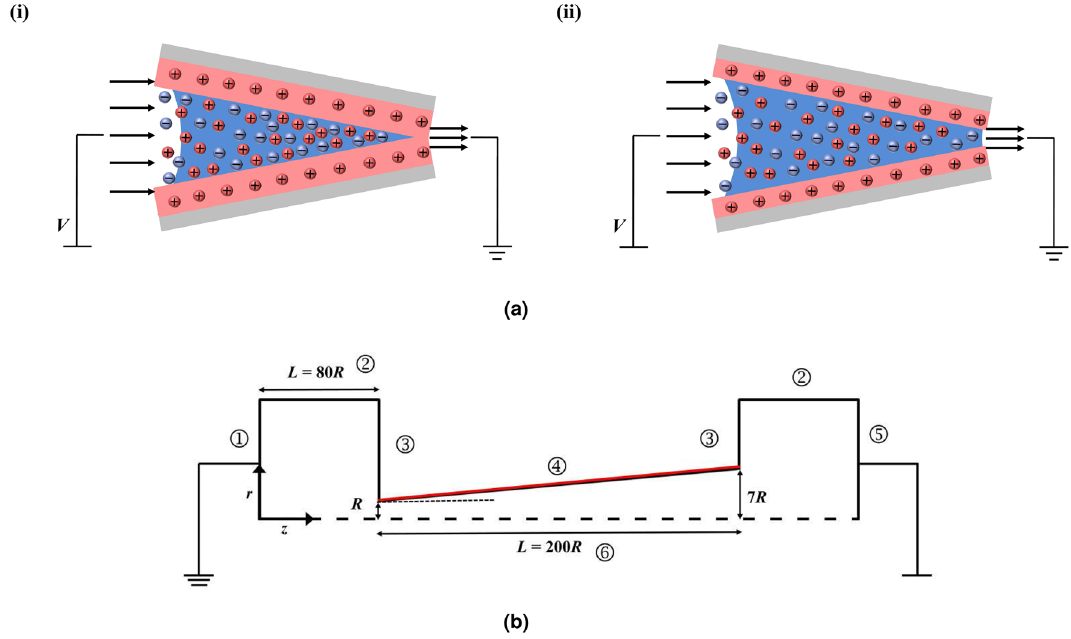
Figure 1. (a) Conical nanopore with a forward potential bias. The electric double layer is highlighted with the red shading. The blue shading represents the bulk solution. (i) When electric double layers are thick and interaction occurs at the nanopore tip (ii) When they are thin and there is no interaction. Dimensions are not to scale. (b) Schematic diagram of computational